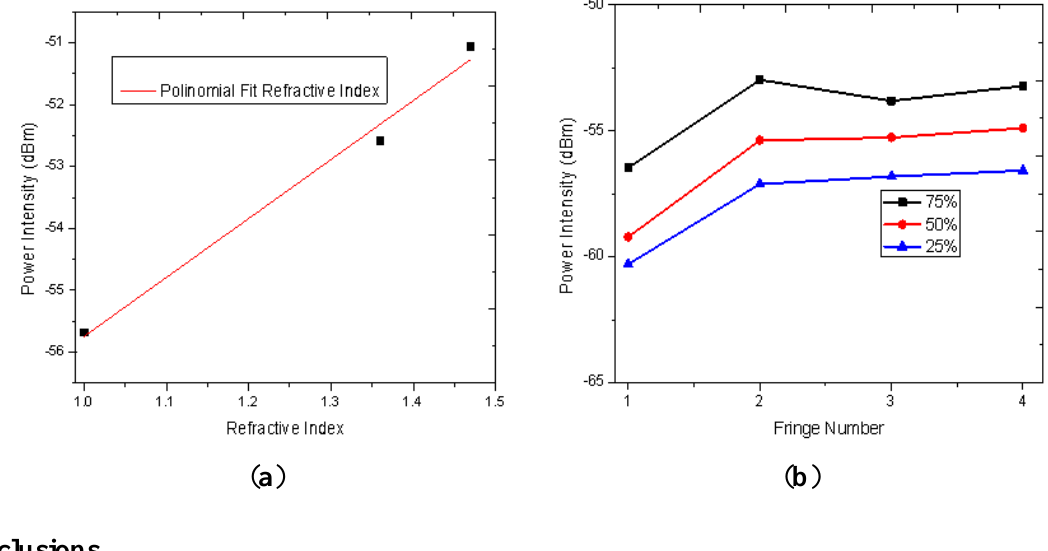
Figure 8. Refractive Index and Fringe contrast response: ( a ) Refractive index contrast intensity variations; ( b ) Fringe contrast variations from alcohol and water